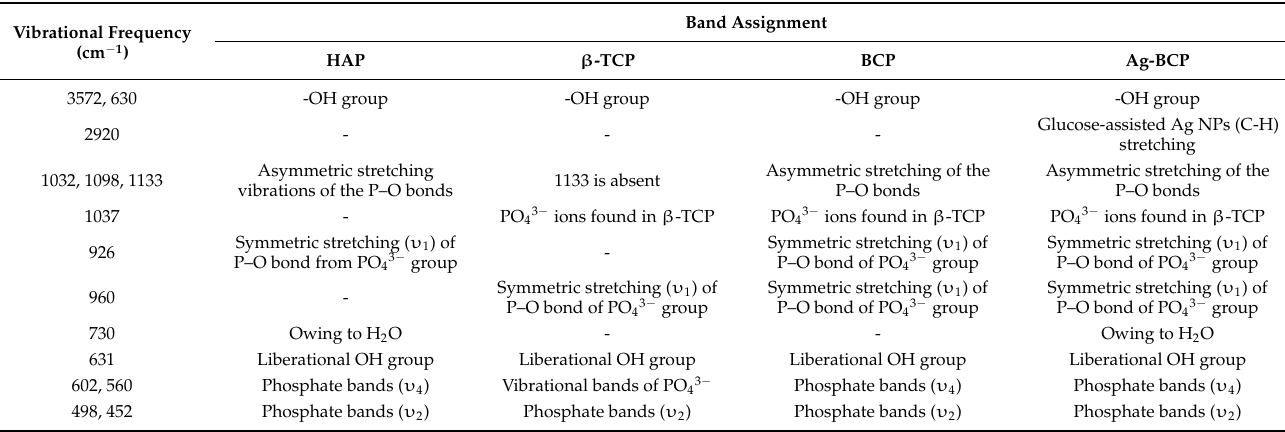
Figure 1. Comparison of the FTIR spectra of ( a ) HAP, ( b ) β -TCP, ( c ) BCP, and ( d ) Ag-BCP samples. Table 1. FTIR spectral data for (a) HAP, (b) β -TCP, (c) BCP, and (d) Ag-BCP samples.